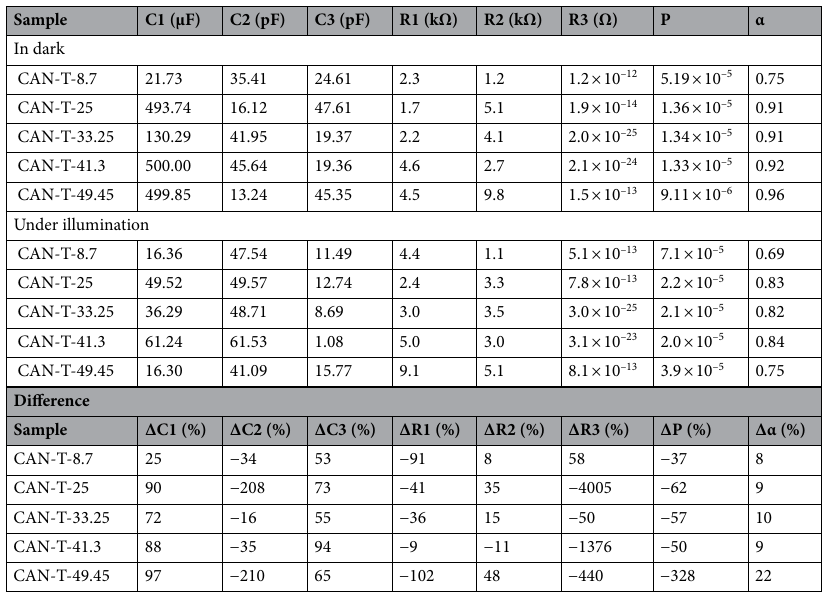
Table 3. Values of the parameters of the electric circuit model obtained from the fitted Nyquist plots for CAN-T materials in darkness, under illumination, and the difference between